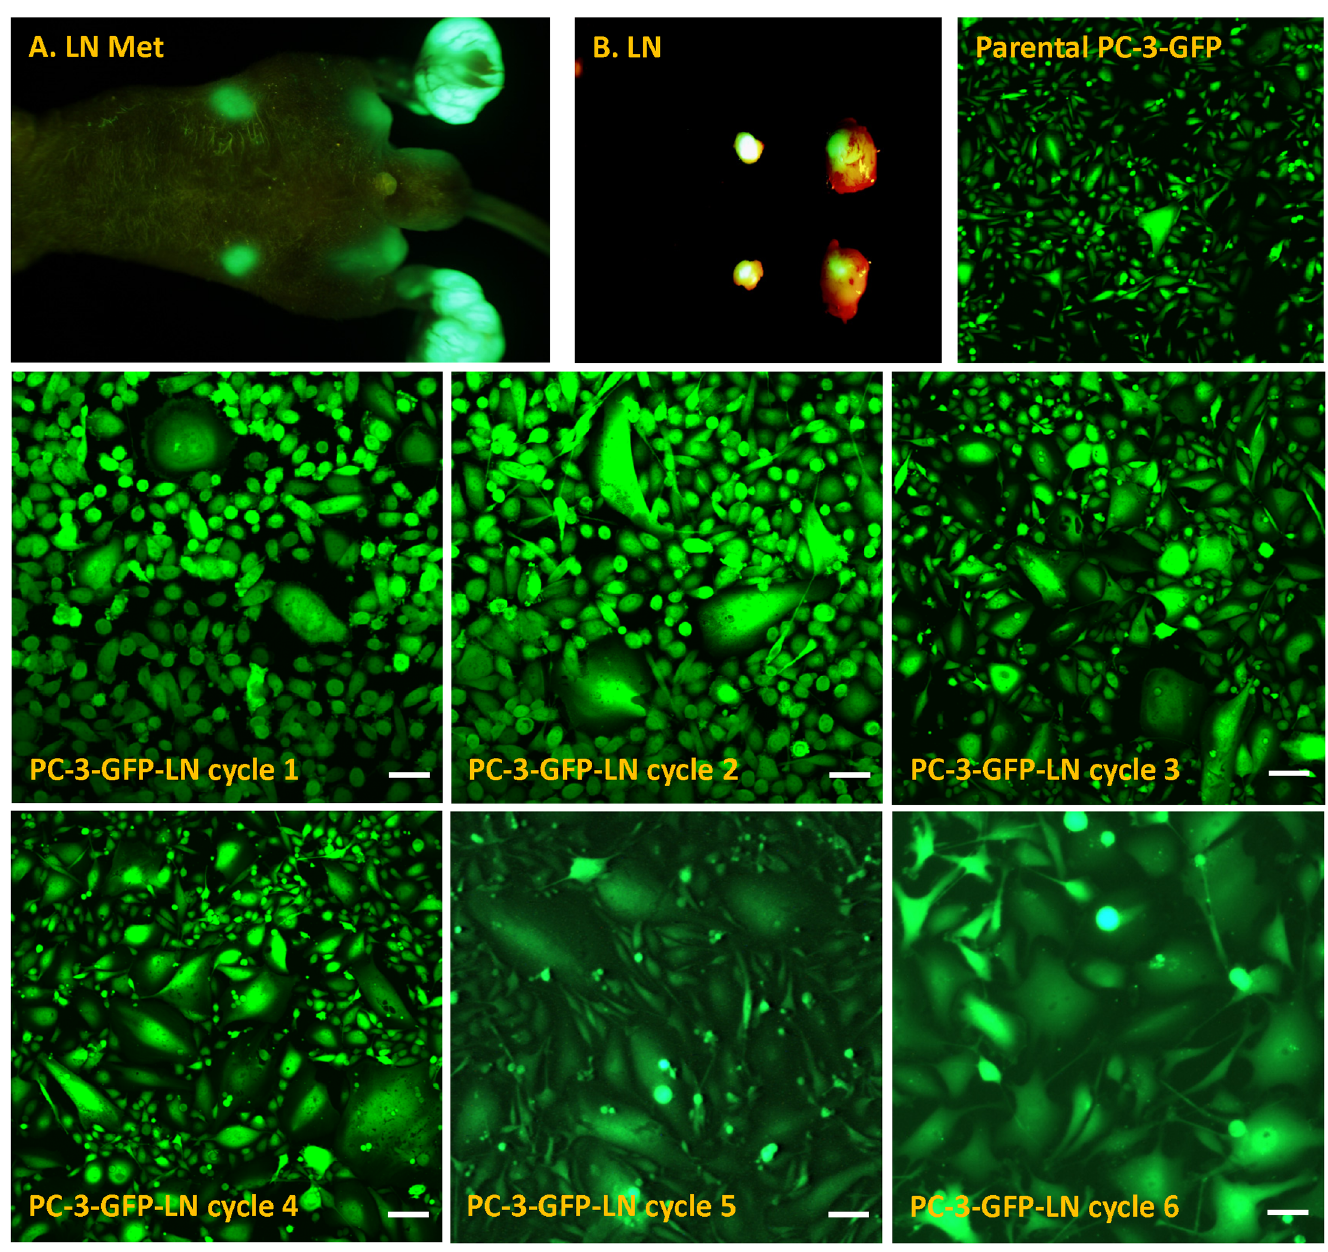
Fig 1. PC-3-GFP cells were injected to the footpad of mice. After 3 weeks, PC-3-GFP developed spontaneous metastasis in the popliteal lymph node and inguinal lymph node. The metastatic PC-3-GFP cells of the inguinal lymph node were collected and re-injected in the footpad to develop variants with increased metastatic potential. The cells in the inguinal node were collected and re-injected the footpad. After 6 such cycles of re-injection and selection of metastasis, the selected cell line developed 100% of metastasis in the lung, bone, inguinal node, axillary node, and cervical node (A&B). The morphology of in vitro cultured metastatic PC-3-GFP-LN cells, from each cycle, cultured from inguinal lymph node metastasis and parental PC-3-GFP are shown. The giant cell number was enriched with the cycle number, indicating that giant cells are more aggressive and highly metastatic cells.